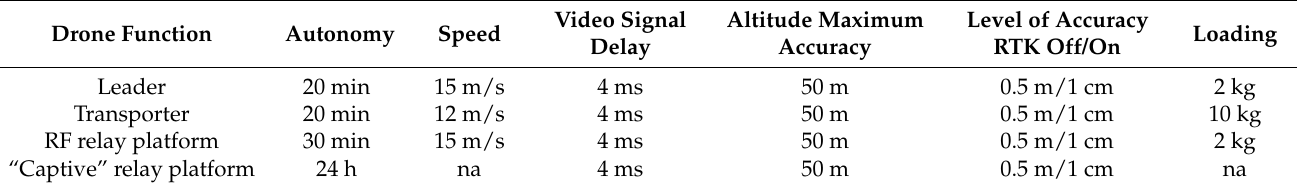
Table 1. Technical